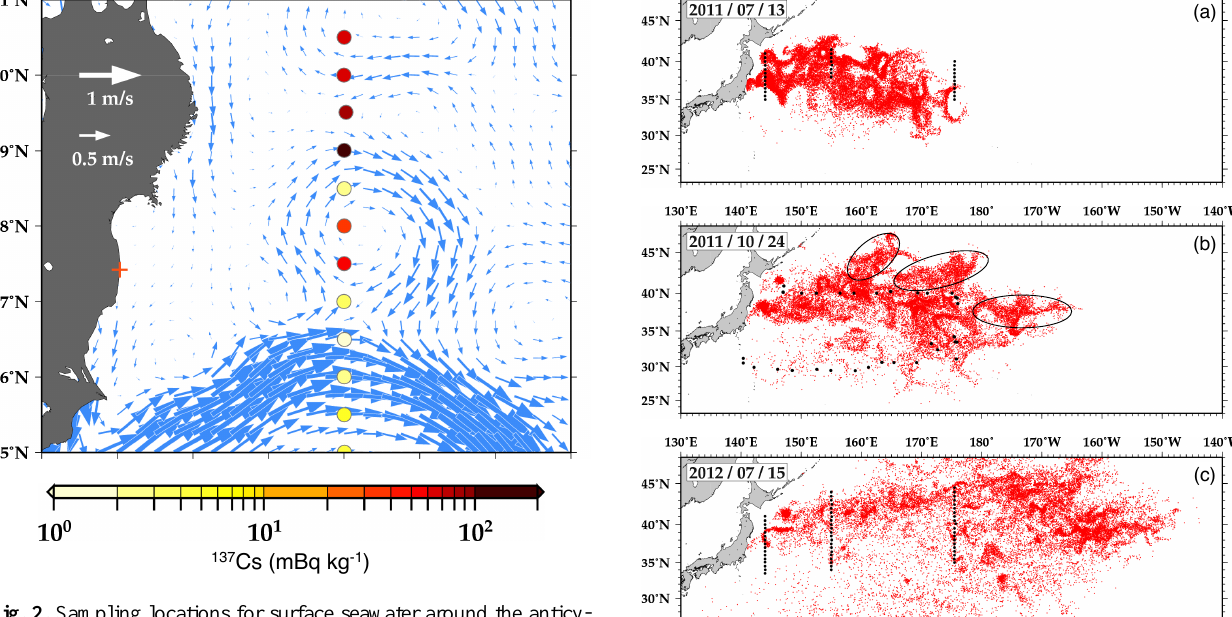
by the oceanic mesoscale motions on an instantaneous